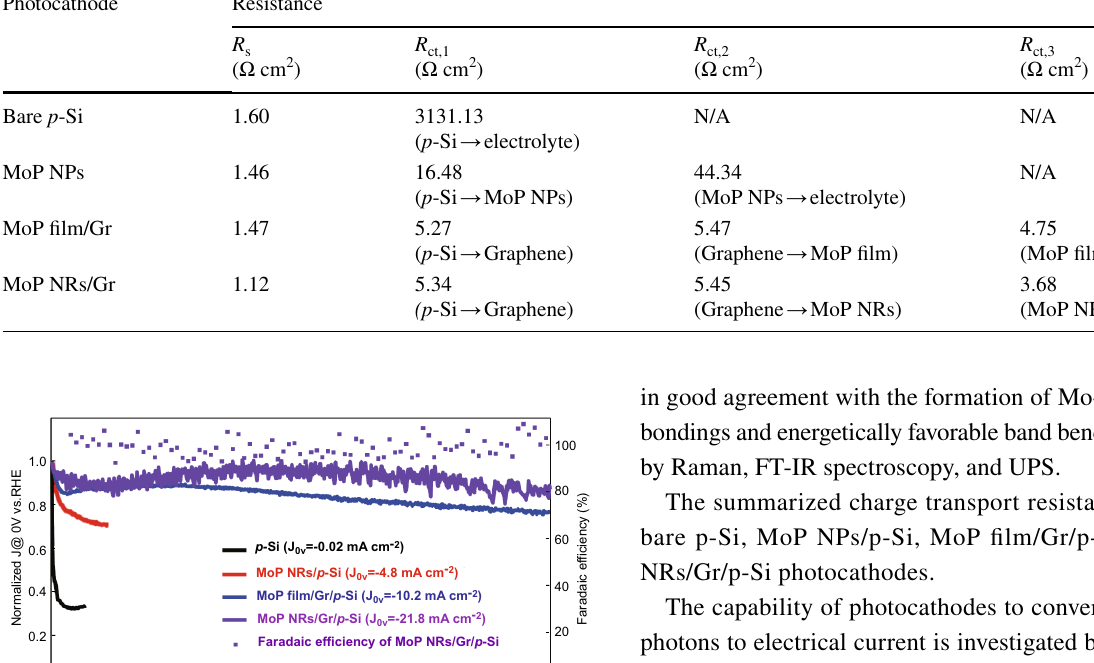
Table 1 Exact values of fitted charge transfer resistance corresponding to each interface. Photocathode